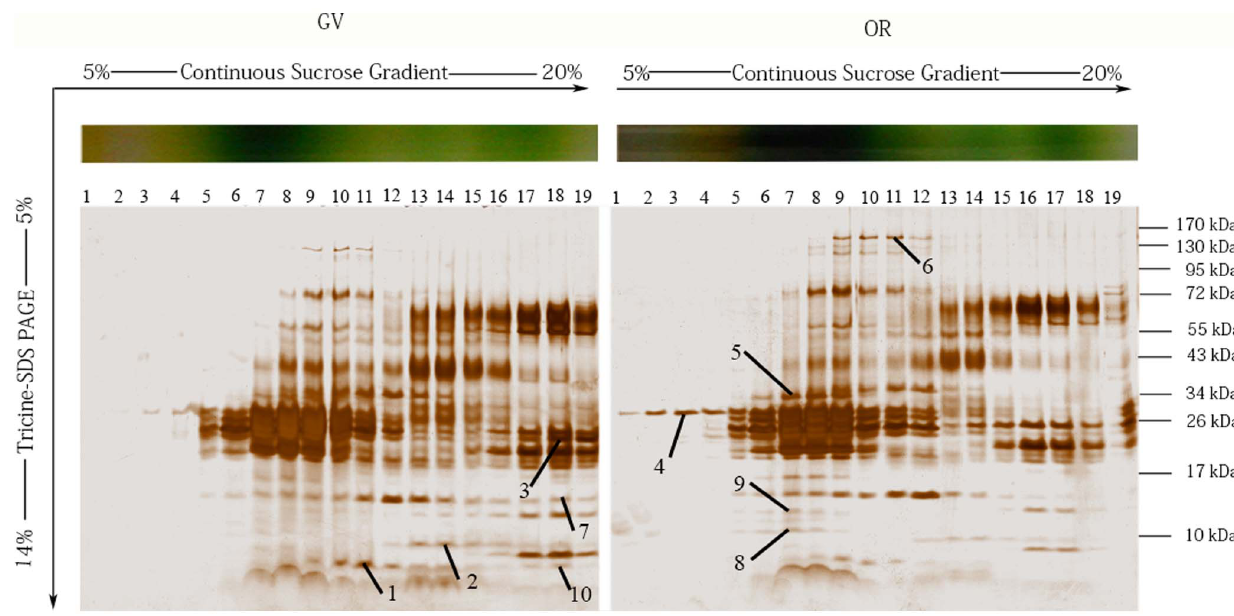
Figure 7. Representative map of protein bands resolved by ultracentrifugation followed by SDS-PAGE. Membrane proteins from GV and OR were fractionated by sucrose ultracentrifugation followed by 7%–14% linear gradient SDS-PAGE. Protein bands were visualized by silver staining. Three replicates for each group were quantitatively analyzed using Quantity One gel analysis software (version 4.6.9, Bio-Rad). 10 most upregulated protein bands were numbered from 1 to 10 as shown in the figure. kDa, kilo-dalton(s).